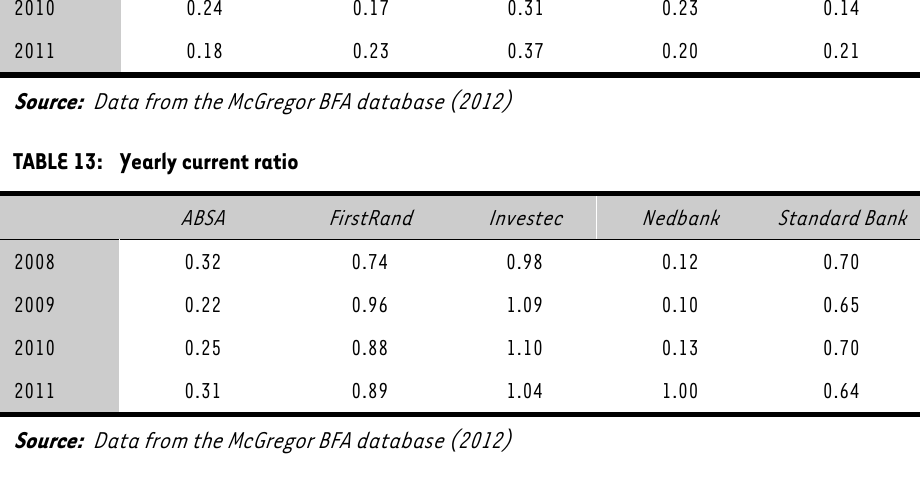
TABLE 14: Efficiency estimates: ABSA Technical efficiency: